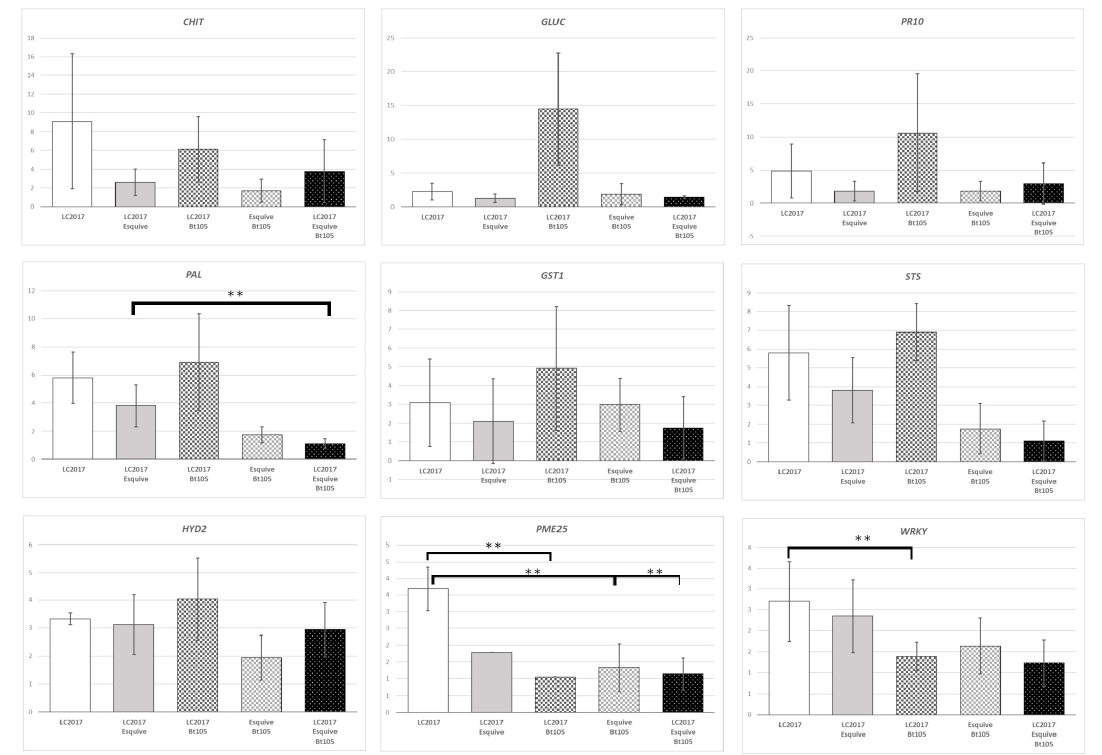
Figure 7. Overexpressed genes (values > 2) at T0 + 2d in Touriga Nacional cuttings with single (LC2017) or double (LC2017 + Esquive ® ) treatment, not inoculated or inoculated with L. theobromae strain Bt105. Statistical analysis with the Mann-Whitney U test showed no significant differences between the medians of LC2017 and LC2017 + Esquive ® and between LC2017 + Bt105 and LC2017 + Esquive ® + Bt105. Only a significant effect of pathogen presence was observed in some genes in LC2017-treated vines and in double-treated vines. The asterisk indicates a statistical significance (Mann-Whitney U test) between the medians of the two considered conditions. ** = p <